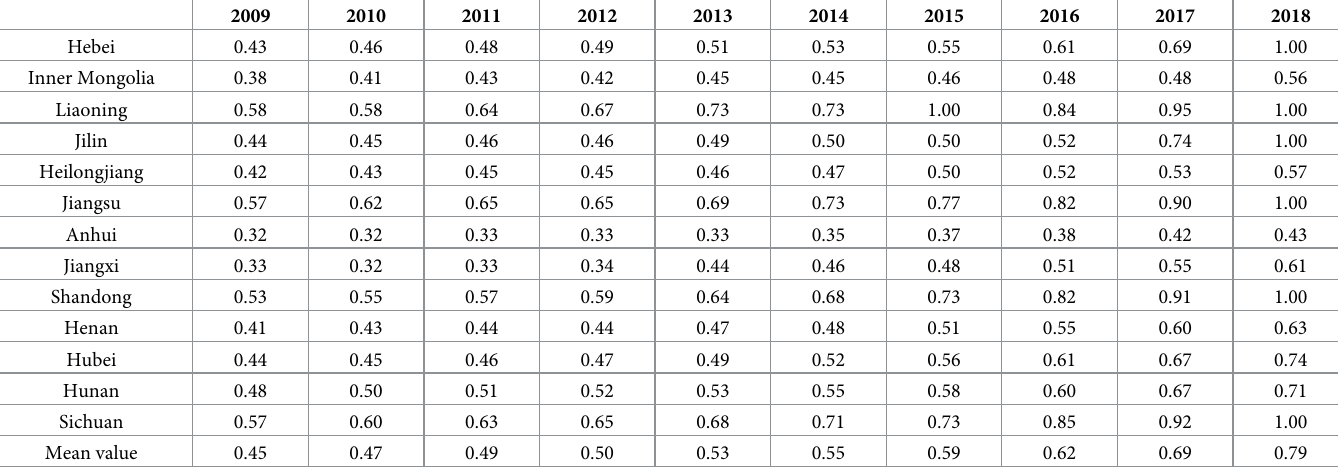
Table 3. Agricultural ecological efficiency in the 13 major grain-producing areas in China, 2008–2018.